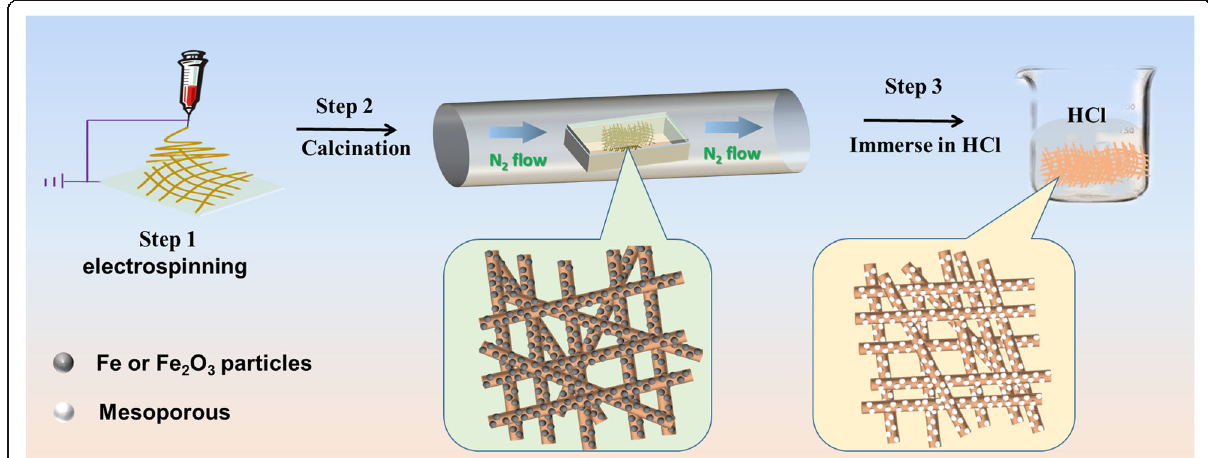
Fig. 1 Illustration of the Fe-N-C mesoporous nanofiber preparation steps